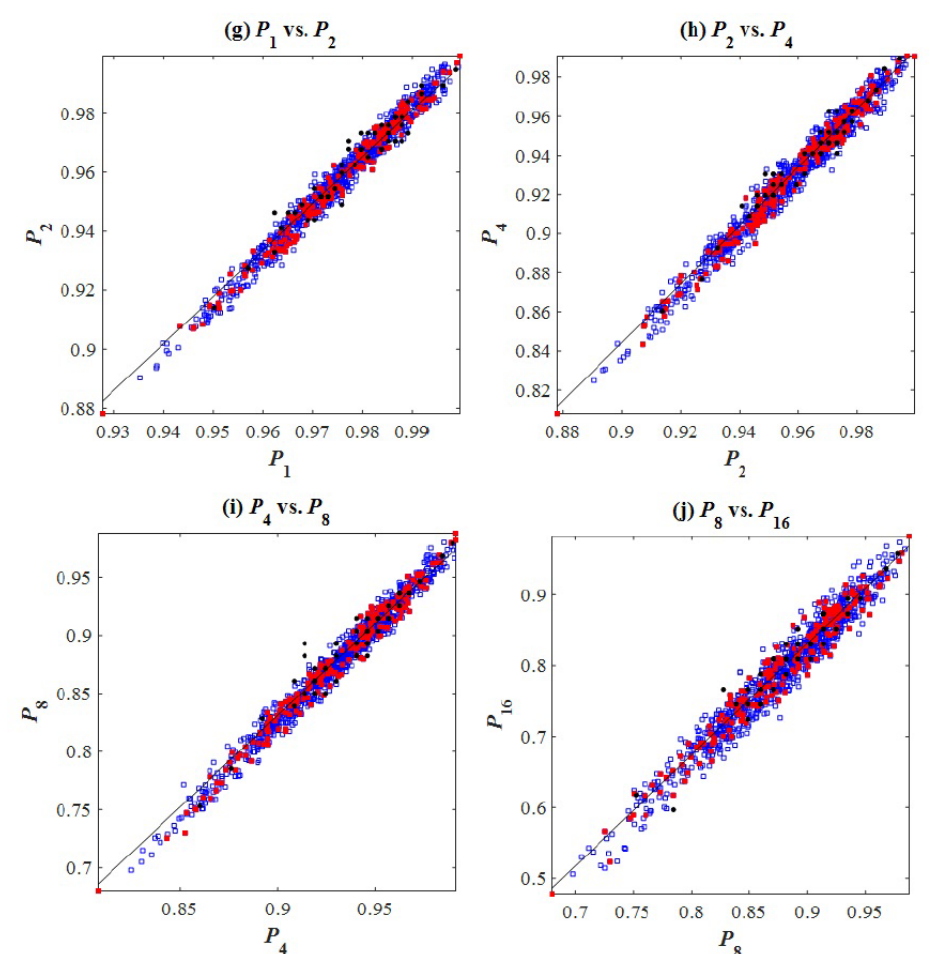
Figure 6. Linear relationship between various fine-timescale statistics of the rainfall observed for the month of July of different years at gauge NCDC-200164 (black dots). The solid black line represents the least-squares regression line. Based on this regression relationship, a set of the 20 fine-timescale statistics are generated, which are immediately used as the basis of the MBLRP model parameter calibration. If the objective function of the parameter calibration corresponding to the generated set is greater than a given threshold, the set is rejected (blue squares), and only the set with the objective function lower the threshold value is chosen (red